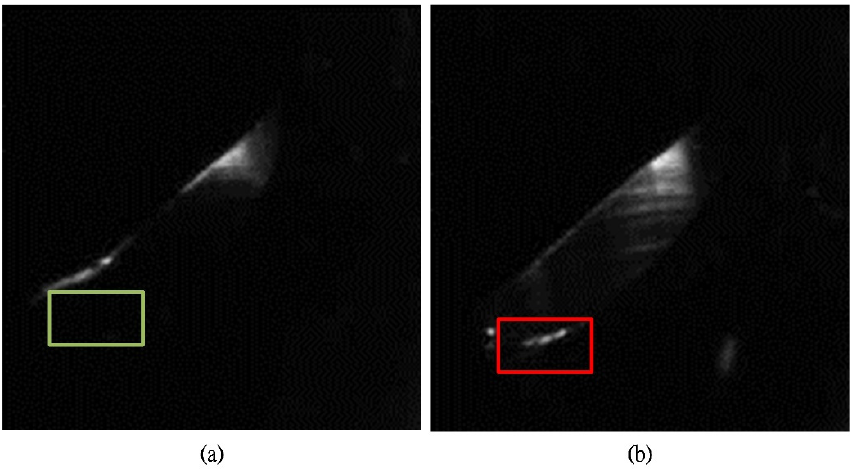
Figure 5. Enlargement for the comparison chart of the ( a ) OK image and ( b ) NG defect image.